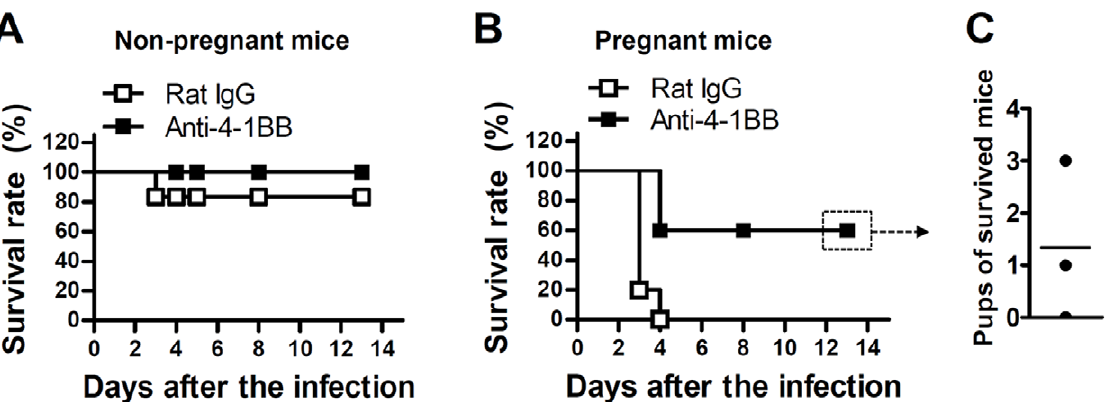
Figure 4. Anti-m4-1BB protects pregnant mice from LM infection. (A) Non-pregnant or (B) pregnant C57BL/6 (at 8 dpc) mice were infected i.v. with 5 6 10 3 CF of LM and concurrently injected i.p. with anti-4-1BB mAb, or rat IgG as a control (n =5). Pup numbers were counted 13 days after infection of the 4-1BB-injected pregnant mice (C). Experiments were repeated two (A) or three (B and C) times with similar results.